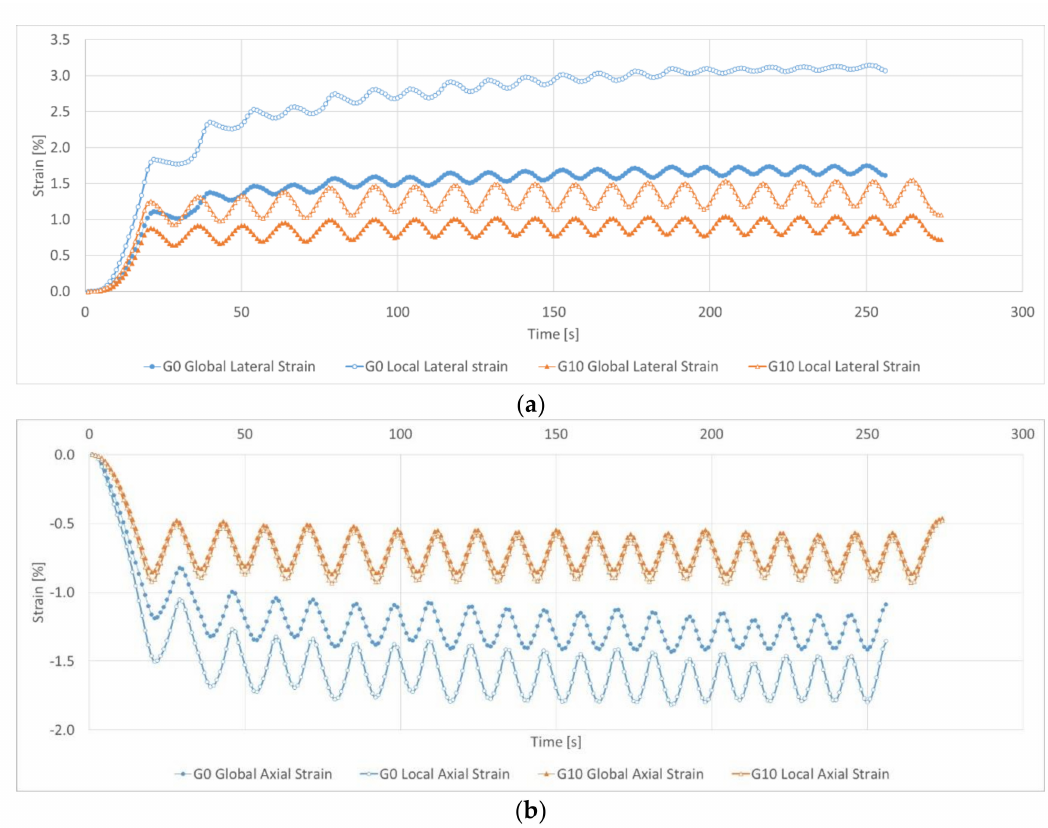
Figure 13. Time dependence of global and local strains (cyclic loading of samples): ( a ) lateral strains of G0 and G10 samples; ( b ) axial strains of G0 and G10 samples.